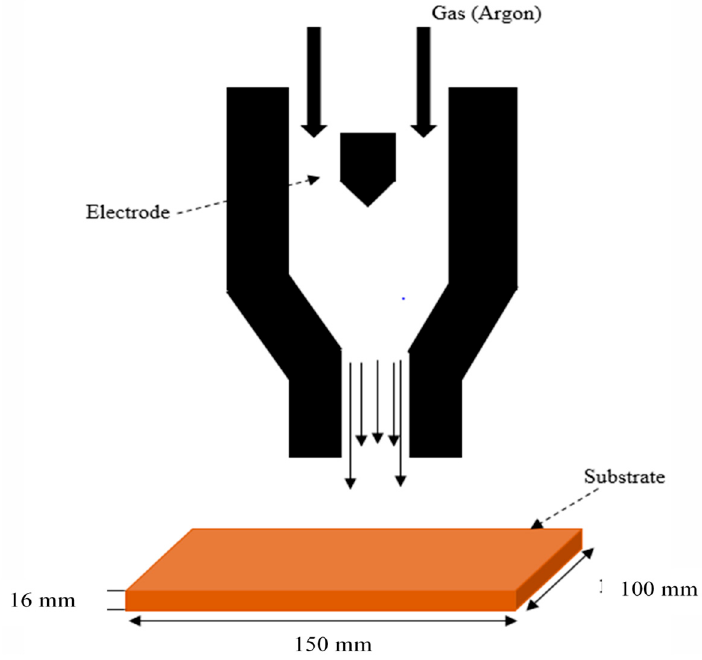
Figure 1. Schematic of plasma treatment.